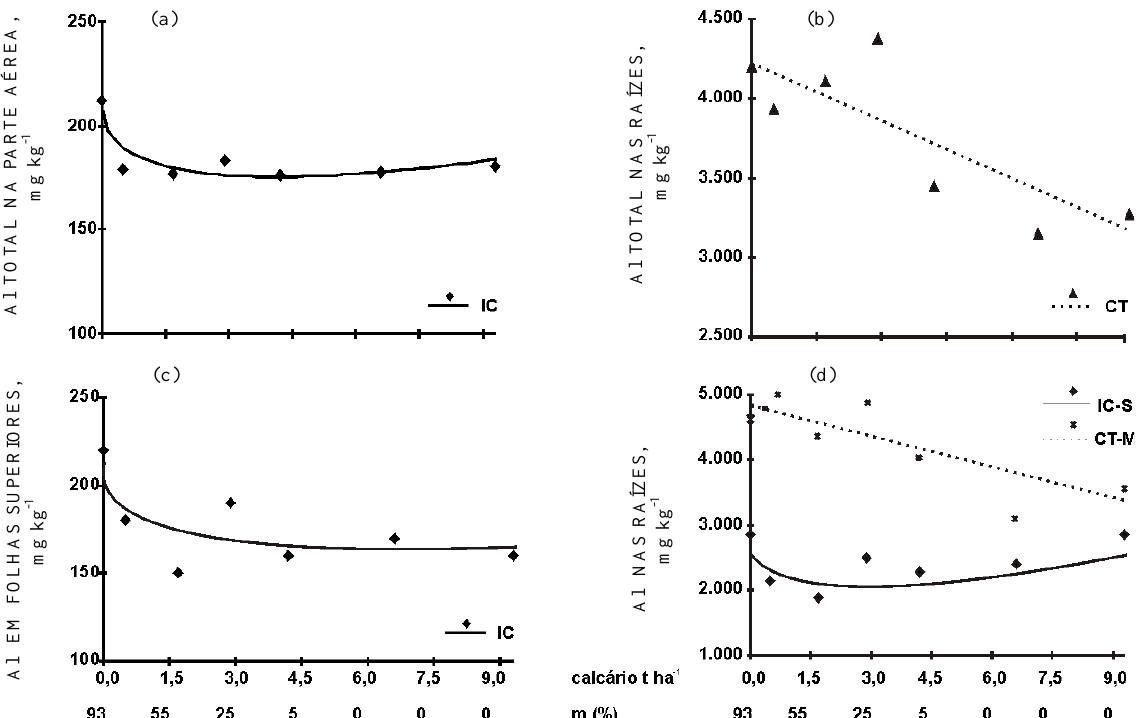
Figura 1. Teores de Al na parte aérea e raízes de duas variedades de cafeeiro, Icatu (IC) e Catuaí (CT), em função das doses de calcário aplicadas na subsuperfície do solo. a - parte aérea total; b - raiz total; c - folhas superiores (FS), d - raiz do anel superior (S), raiz do anel mediano